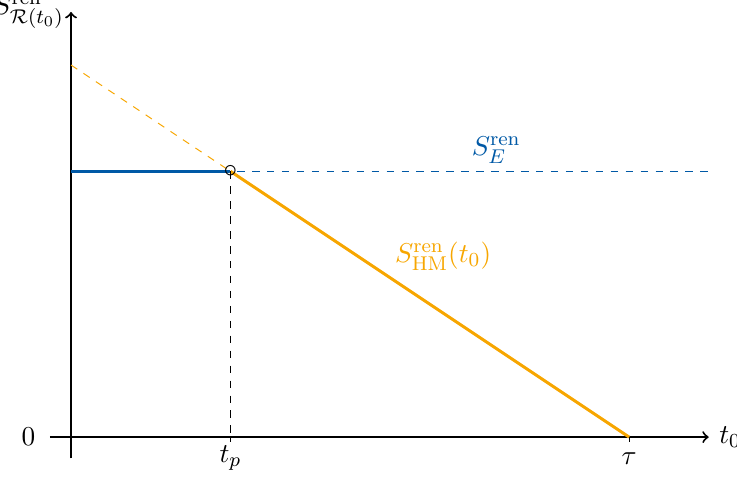
, as a function of R ( t 0 ) ( t ) and A ren , respectively. The entropy 0 E HM